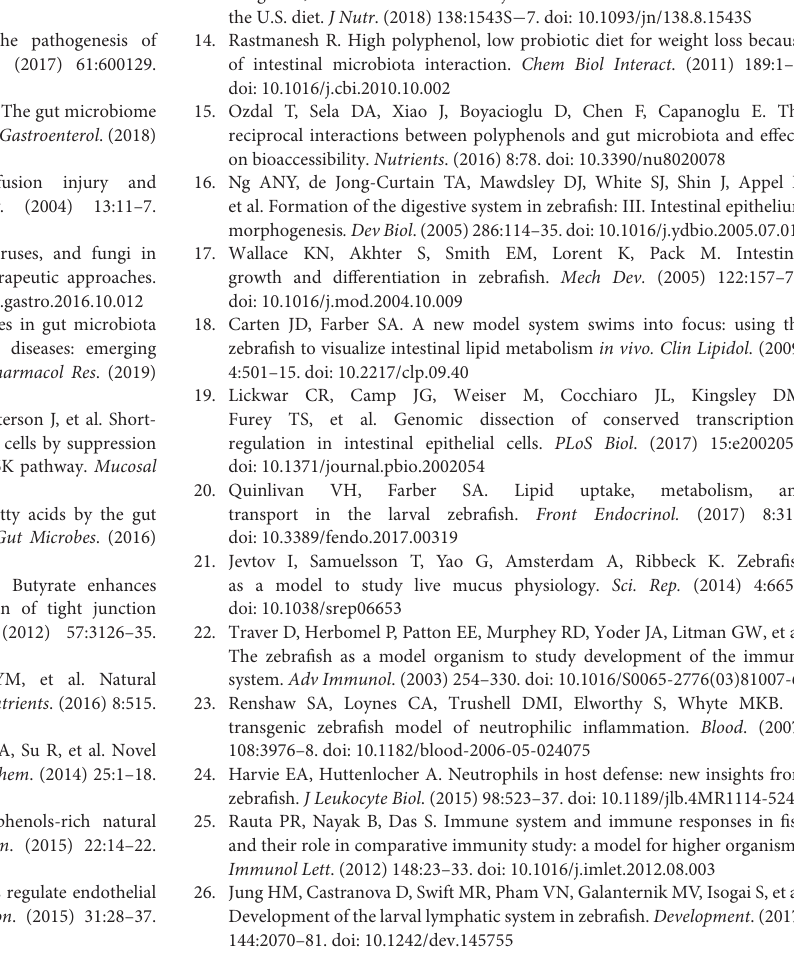
Supplementary Figure 3 . Structural changes of intestinal flora on the phylum in each group within 21 days is shown in Supplementary Figure 4 . KEGG analysis of genes differentially expressed in each group of tertiary metabolic pathways at different time points, as shown in Supplementary Figures 5, 6